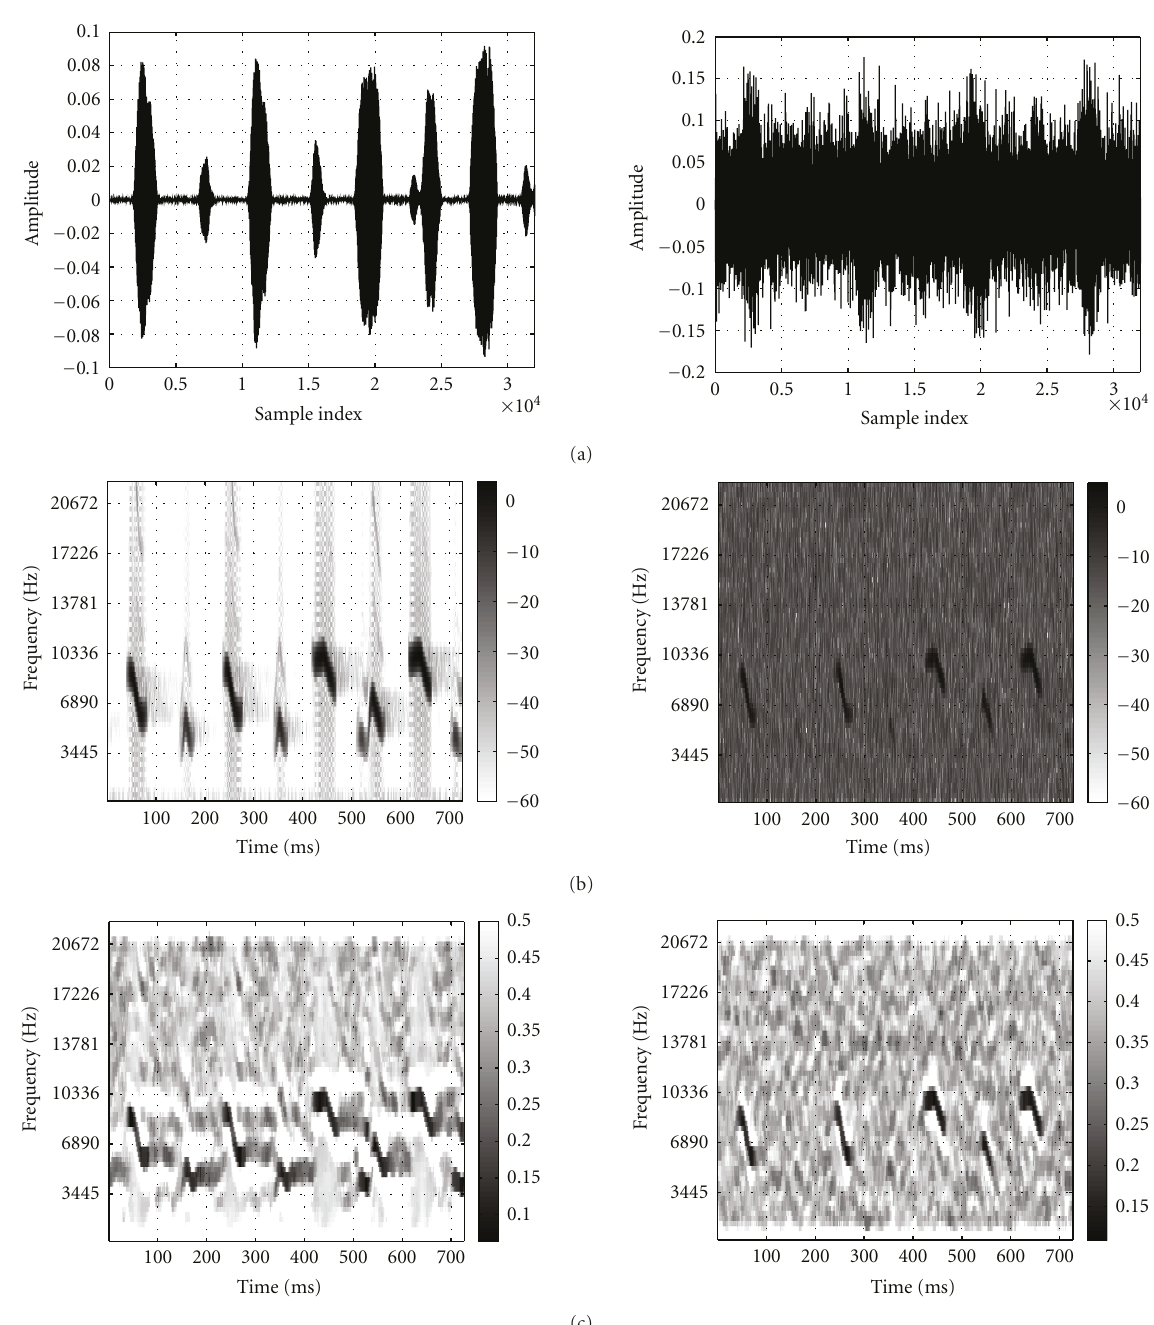
Figure 1: Waveform (a), spectrogram (b), and the corresponding sine-distance values (c) of a tonal bird song which is clean (left) and corrupted by White noise at the global SNR of − 10 dB